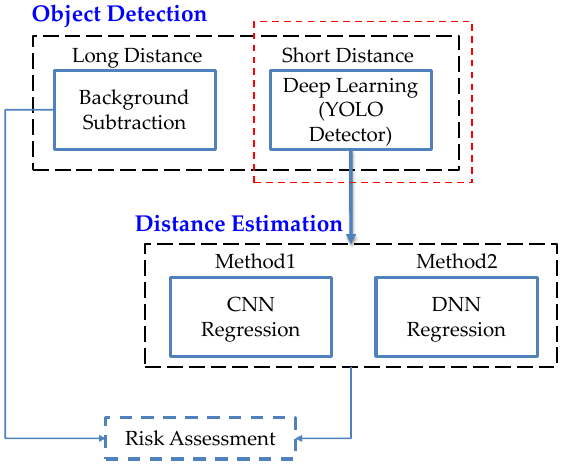
Figure 1. Flow chart of research process.